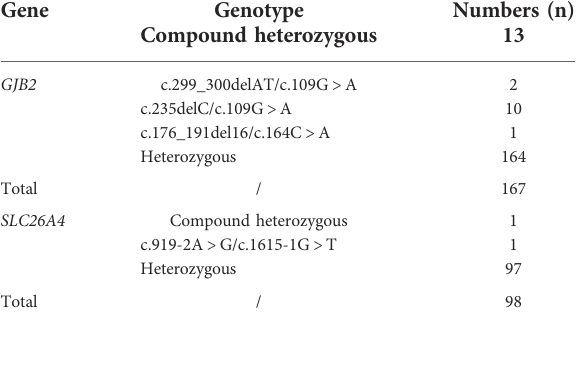
TABLE 5 Results of the entire coding regions sequencing of GJB2 and